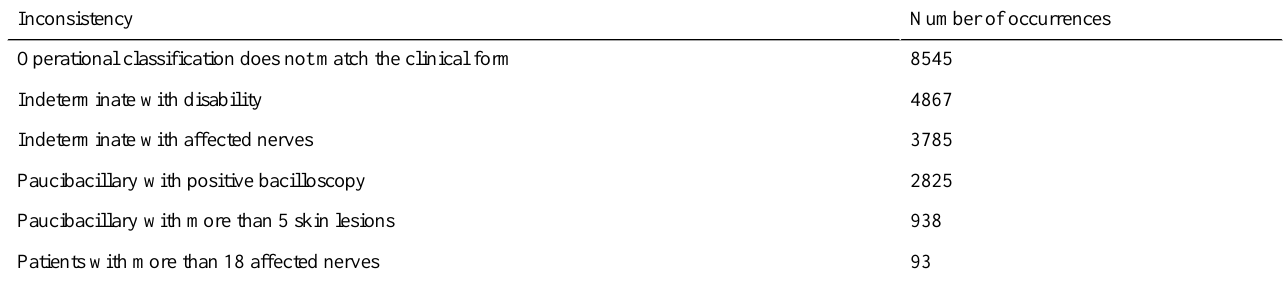
Table 2. Number of occurrences per inconsistency.